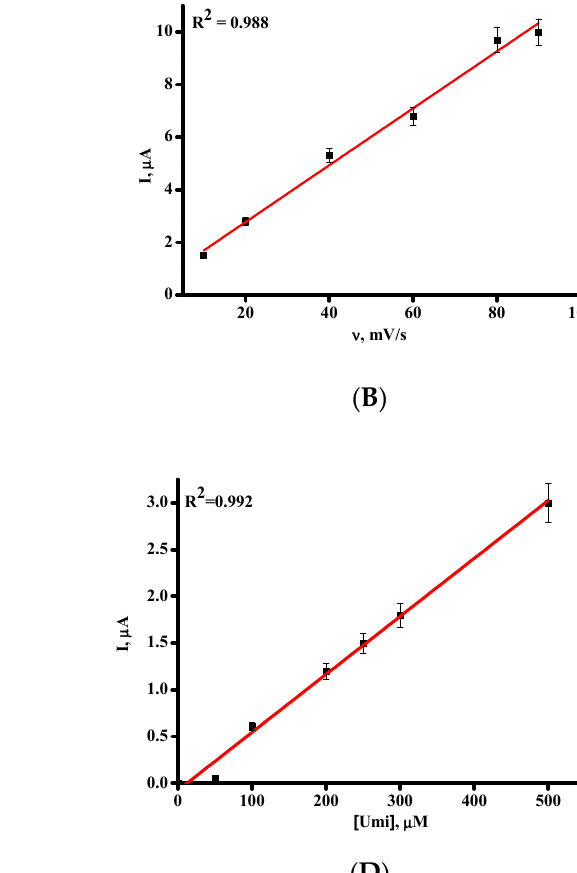
(LOD) and the limit of quantification LOQ) were calculated from the calibration curve as kSD/b (k = 3 for LOD, k = 10 for LOQ), b = slope of the calibration curve, SD = standard deviation of the intercept [26,37] (Table